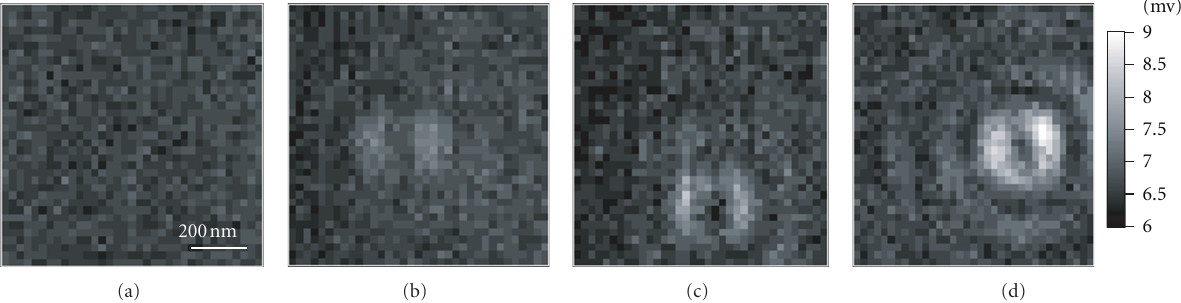
Figure 5: Scattering images of the s -polarization laser focus measured by the probes with di ff erent silver coatings. The images (a)–(d) correspond to the probes shown in Figures 4(a)–4(d), respectively. The contrasts in the images correspond to the s -polarization sensitivities of these probes.